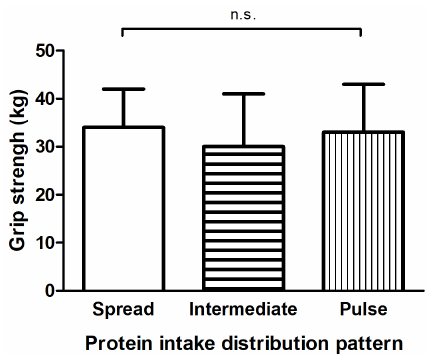
Figure 2. Hand grip strength of 3 groups based on distribution pattern of protein intake during the main meals determined with CV (coefficient of variance). Participants in the spread group ( n = 46, CV < 0.43), intermediate group ( n = 48, CV 0.43–0.62) and pulse group ( n = 46, CV > 0.62) had similar grip strength. N.s., not significant. Data are presented as means ± SDs.